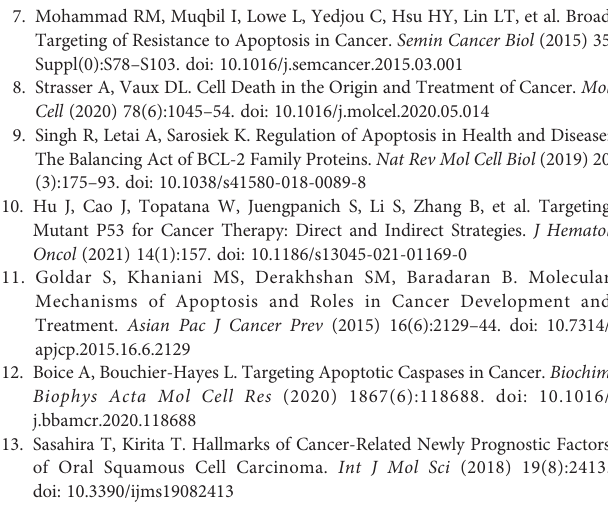
Supplementary Figure 1 | The heatmap showed expression pro fi le of the 6 risk genes in pan-cancer. Supplementary Figure 2 | Forest plotshowed the correlation of 6 risk geneswith the prognosis in